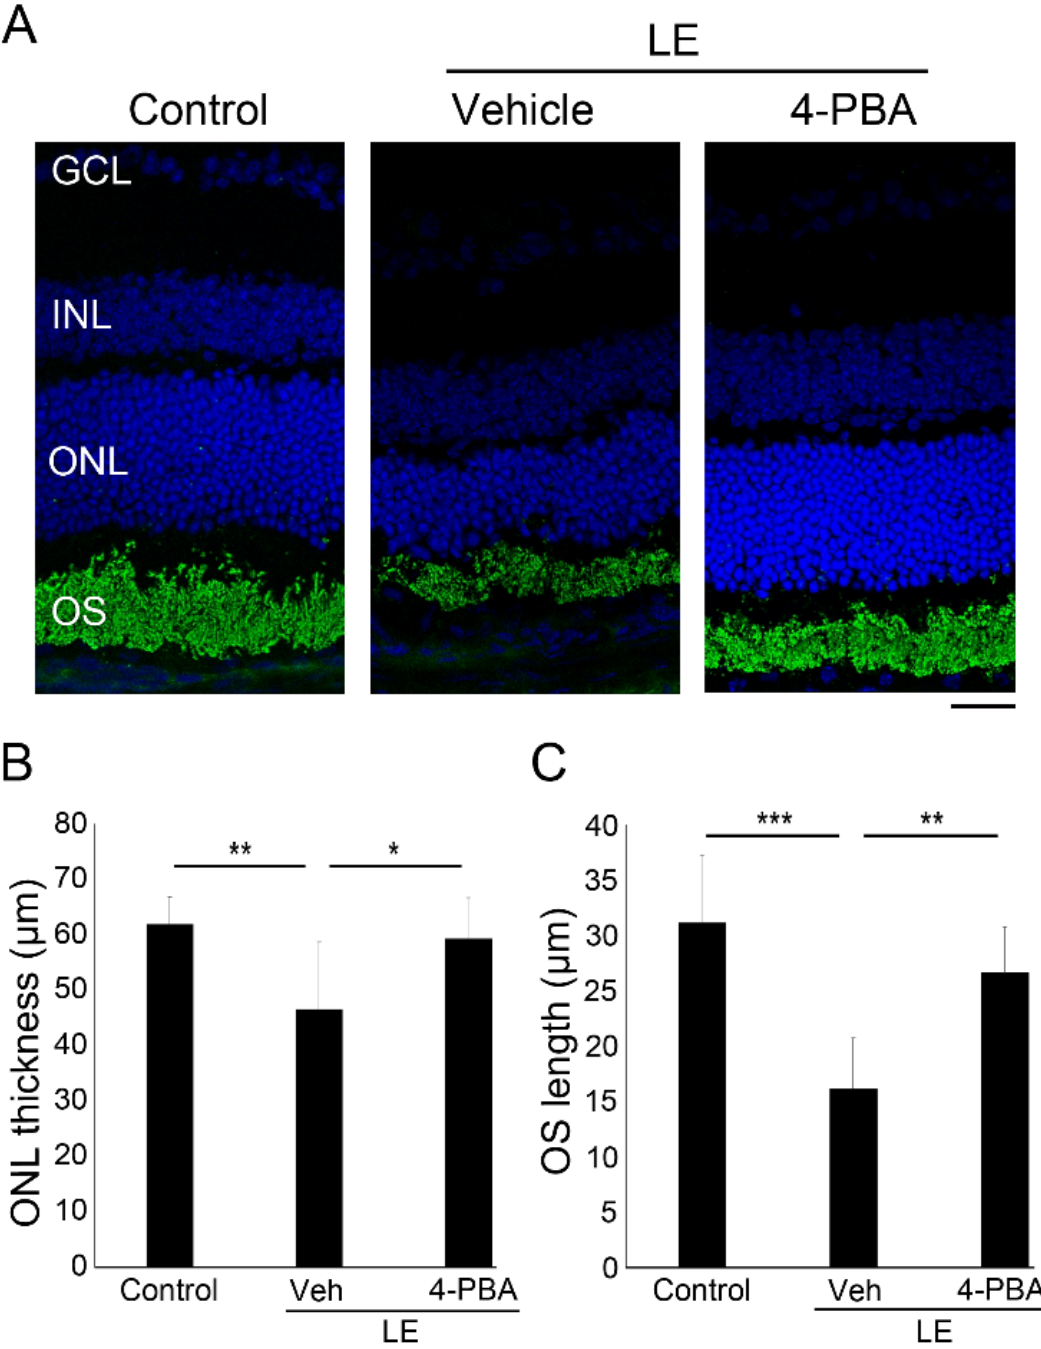
Figure 2. 4-PBA suppressed light-induced photoreceptor histological changes and degeneration. ( A ) Representative images of immunohistochemistry for rhodopsin (green) counterstained with 4 (cid:48) ,6-diamidino-2-phenylindole (DAPI) (blue) 4 days after light exposure with or without 4-PBA treatment. Reduction in ONL thickness ( B ) and OS length ( C ) were suppressed by 4-PBA. LE, light exposure; Veh, vehicle; GCL, ganglion cell layer; INL, inner nuclear layer; ONL, outer nuclear layer; OS, outer segment. Data are presented as mean ± standard deviation. n = 8 in each group. Scale bar, 25 µ m. * p < 0.05, ** p < 0.01, *** p < 0.001. ANOVA with Tukey post-hoc